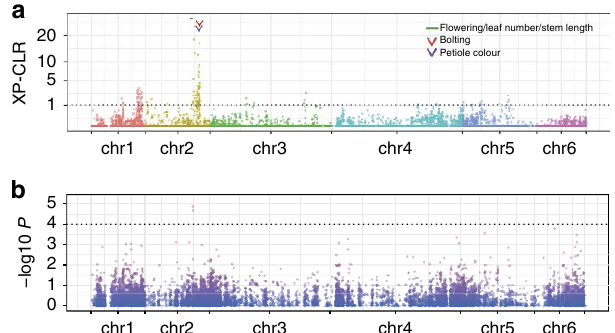
Figure 4 | Genome-wide scan of selective sweeps and GWAS of bolting. ( a ) Distribution of XP-CLR scores across the spinach genomes. The black horizontal dashed line refers to the top 1% threshold. Arrows and the short interval indicate positions of known SNP markers and QTL, respectively, for different traits. ( b ) Manhattan plot of the GWAS for spinach bolting trait. The significance threshold (1 (cid:2) 10 (cid:3) 4 ) is indicated by the black horizontal